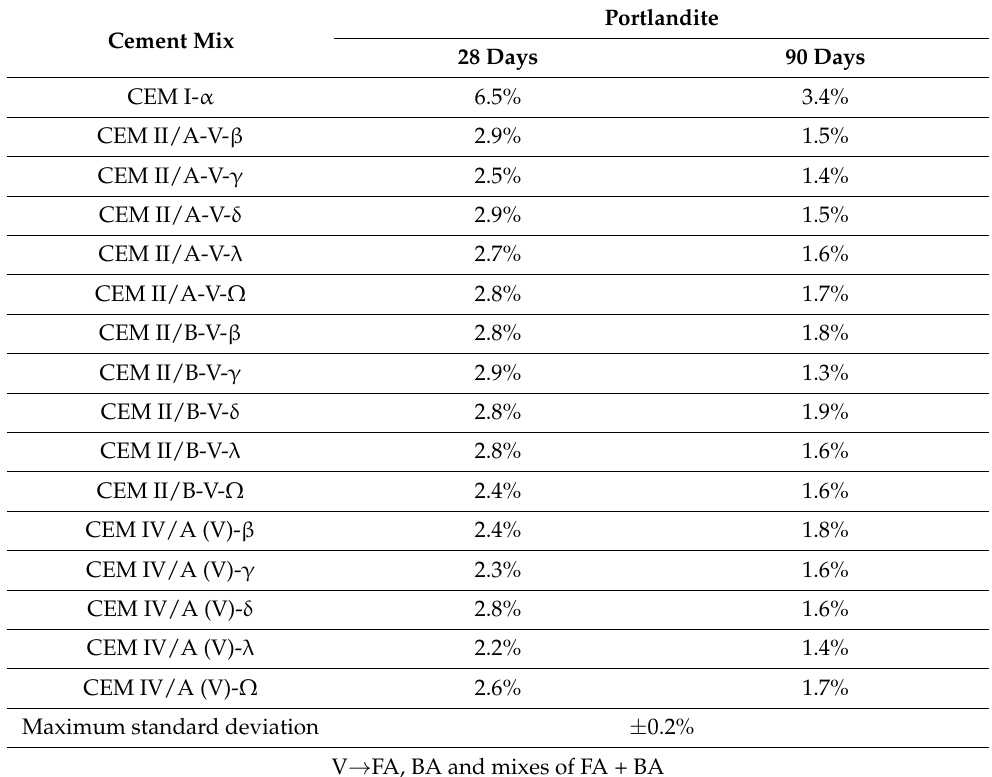
Table 3. Portlandite content determined by